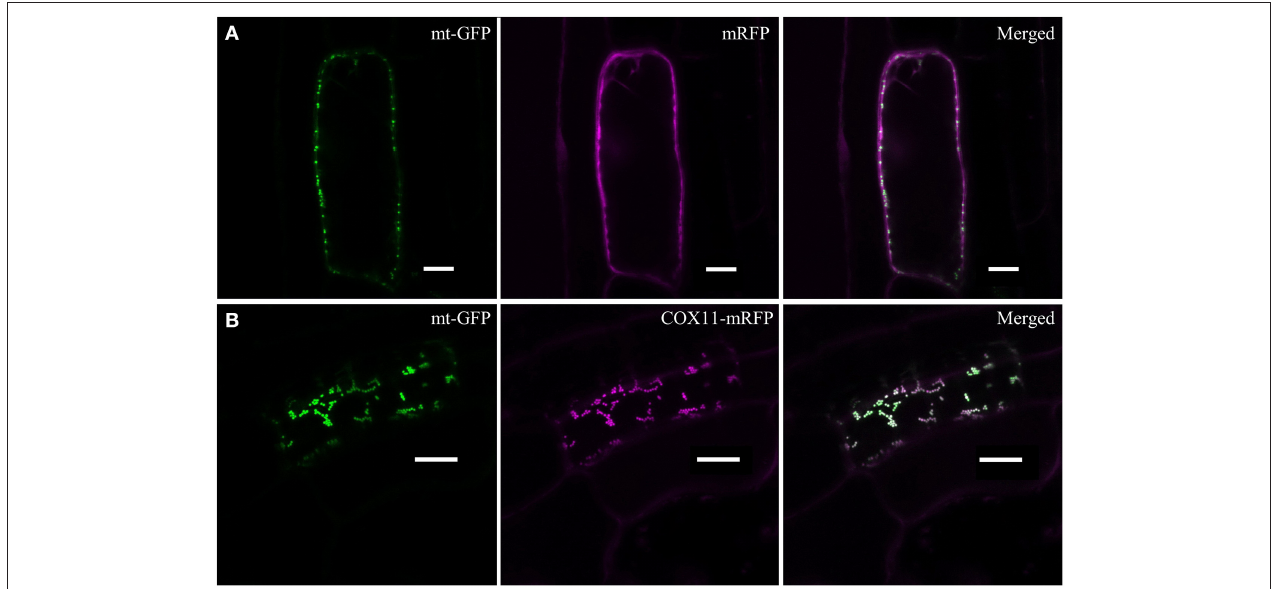
FIGURE 2 | COX11-mRFP is localized to mitochondria. LSM images of root cells from Arabidopsis lines with GFP-labeled mitochondria, expressing either mRFP alone (A) or COX11-mRFP (B) , are shown. The fluorescence of mRFP and GFP targeted to mitochondria (mt-GFP) was falsely colored magenta and green, respectively. Scale bars correspond to 10 µ m